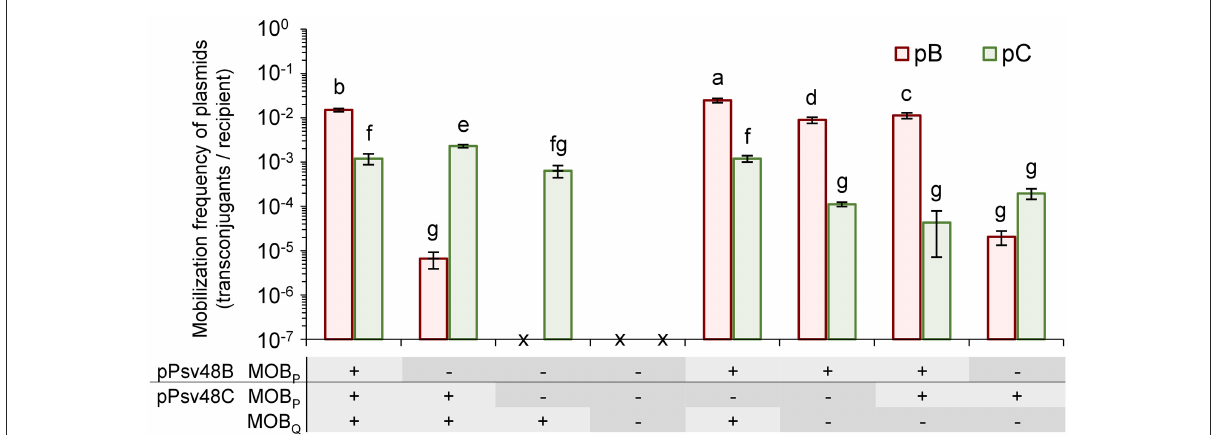
FIGURE4 Role of the three relaxase genes in the conjugal mobilization of pB and pC evidenced by site-directed mutagenesis. Bars indicate the mobilization frequency (mean ± sd) of plasmids pB (orange) and pC (green) in strains containing functional ( + ) or mutated (–) versions of the three relaxase genes, as indicated in the panel below the graph. x, no transconjugants detected. Values are the average of at least three independent experiments, each with four replicates. Means with different letters are significantly different (one-way ANOVA and Duncan’s multiple range test; p < 0.05).